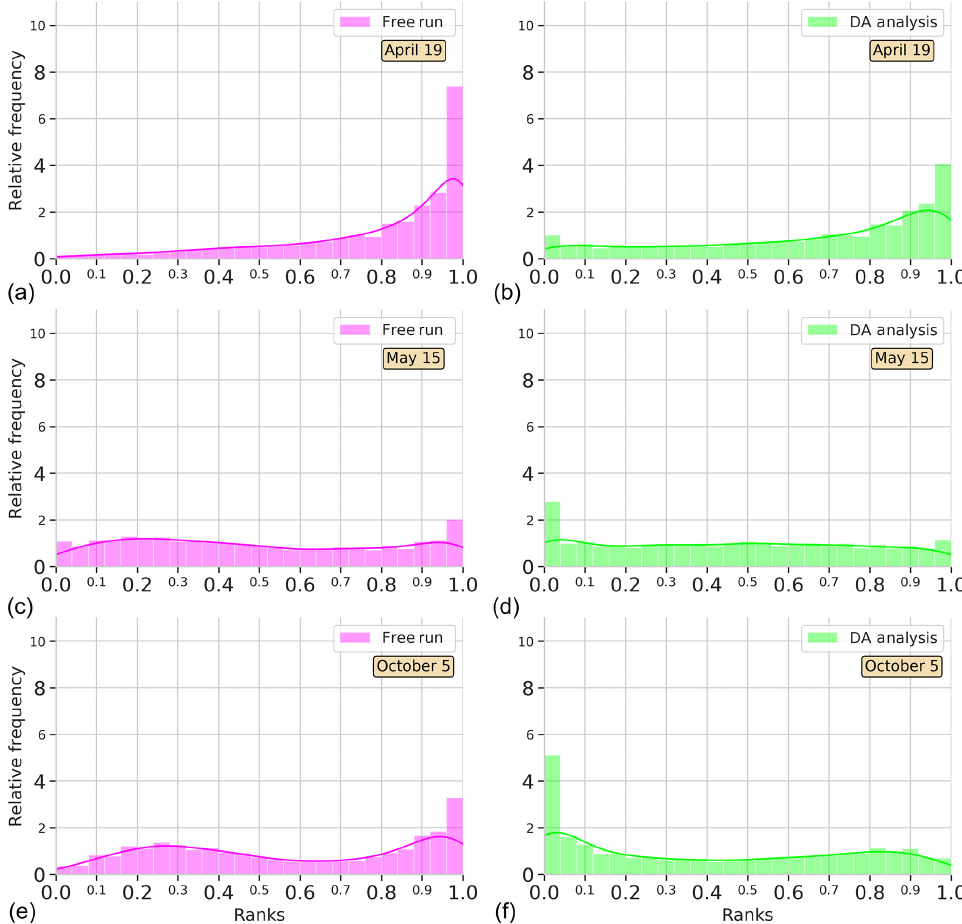
Figure 4. Surface Chl a rank histograms of the 24-member free-run experiment (magenta; a, c, e ) and the 24-member analysis ensemble assimilation experiment (light green: b, d, f ) in comparison with SeaWiFS data for province NADR. Ranks are computed for 19 April, 15 May, and 5 October 2005. A 30% SeaWiFS observation error is taken into